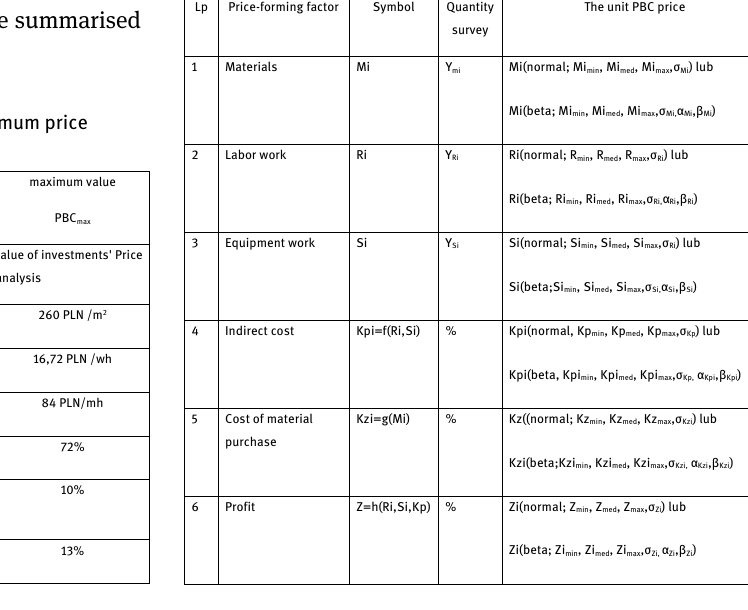
Table 2: Comparison of generalized